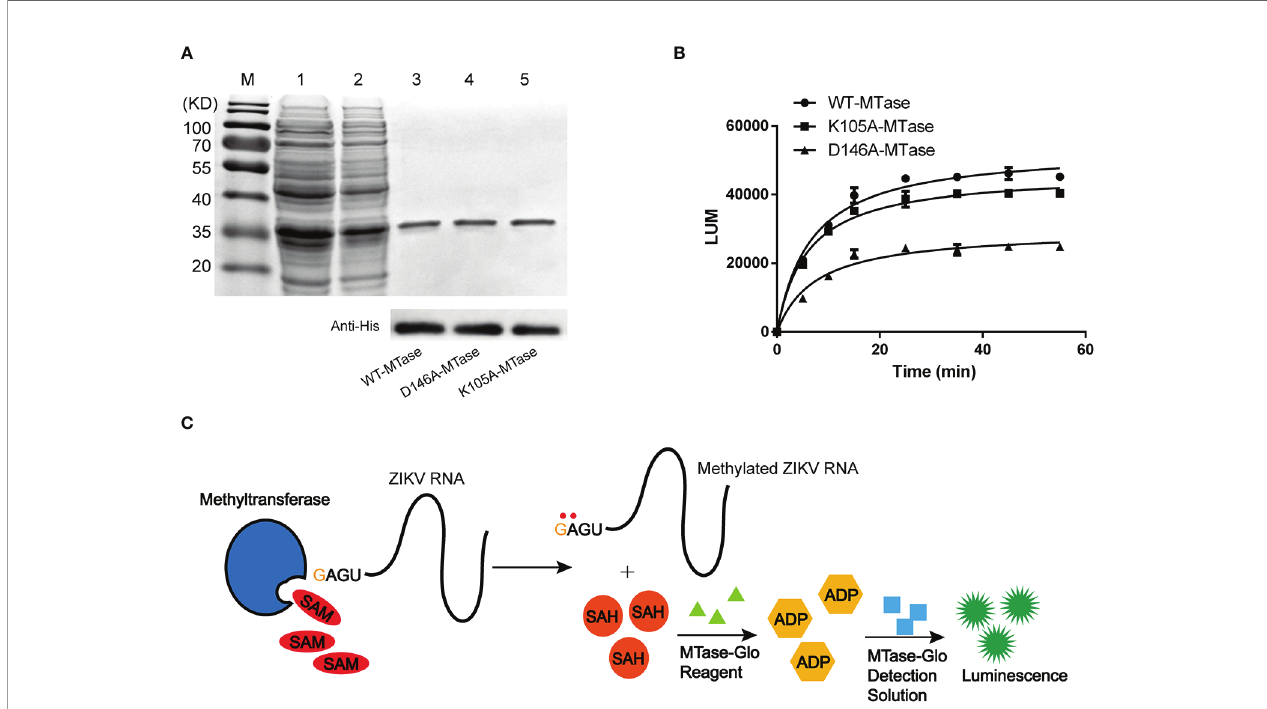
FIGURE 1 | Puri fi cation and characterization of ZIKV NS5 MTase. (A) Puri fi cation of NS5 MTase and its mutants. SDS-PAGE (top) and Western blot (bottom) using anti-His-tag antibody analysis of the recombinant proteins. Lane M, protein marker. Lane 1, total cellular proteins containing induced recombinant WT-MTase. Lane 2, supernatant of cellular lysate containing induced recombinant WT-MTase. Lane 3, puri fi ed recombinant WT-MTase. Lane 4, puri fi ed recombinant D146A-MTase. Lane 5, puri fi ed recombinant K105A-MTase. (B) Activity of recombinant WT-MTase, D146A-MTase and K105A-MTase. Luminescence-based